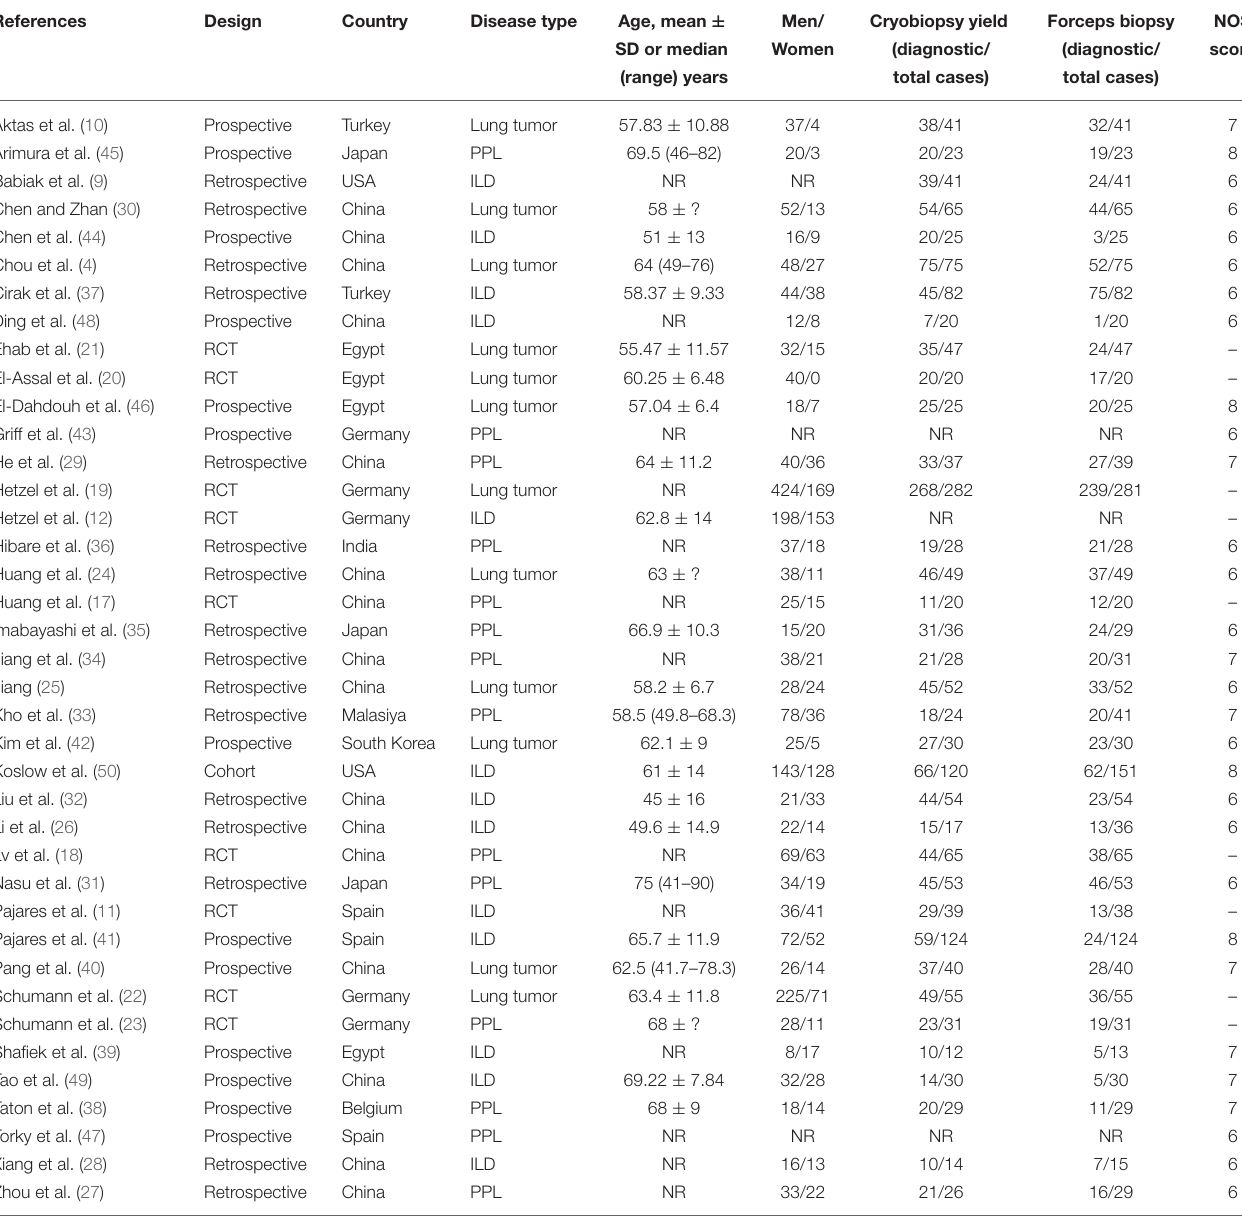
TABLE 1 | Characteristics of included